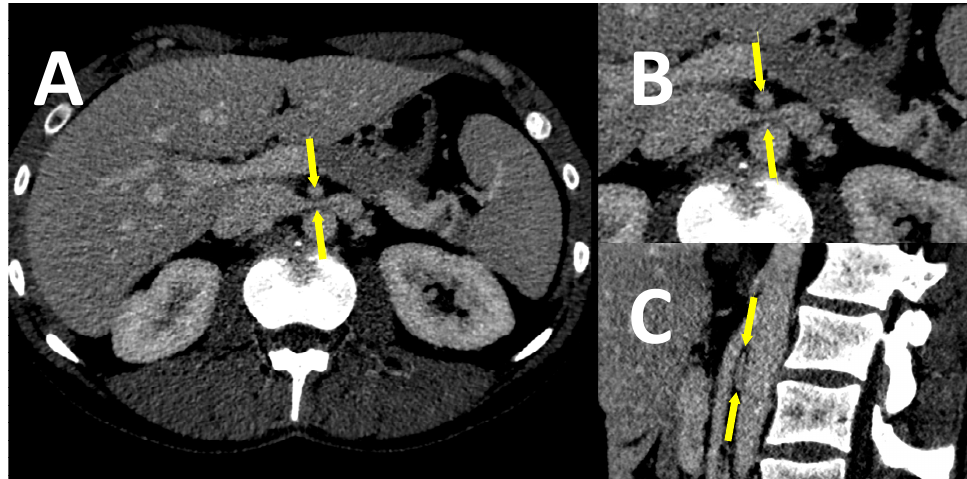
Figure 4. The images of a CT-V scan in a patient with LRV entrapment (“nutcracker” syndrome). LRV (marked with arrows) is compressed between the aorta and superior mesenteric artery (SMA), as shown on the transverse plane—whole image ( A ), enlarged image ( B ), and on the sagittal plane ( C